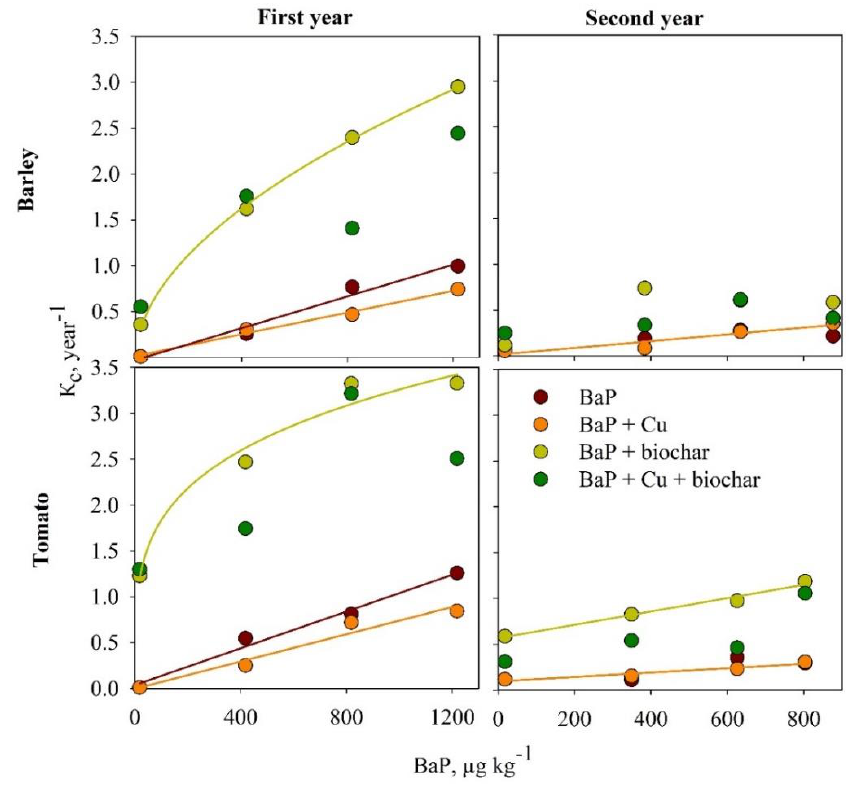
Figure 4. BaP degradation constant (Kc) in the Haplic Chernozem of model vegetation experiment. Note: the line of approximation on the figure indicates the presence of a relationship between the initial BaP concentration and the BaP degradation constant in Haplic Chernozem.